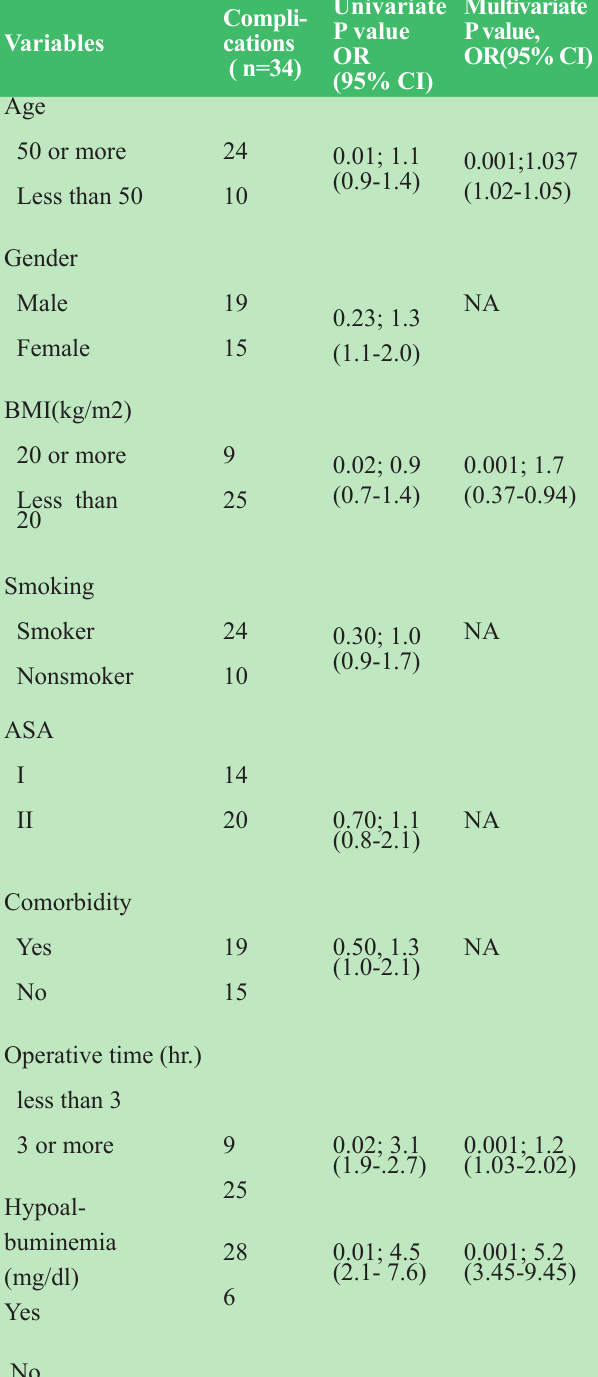
Table 3: Association of variables and